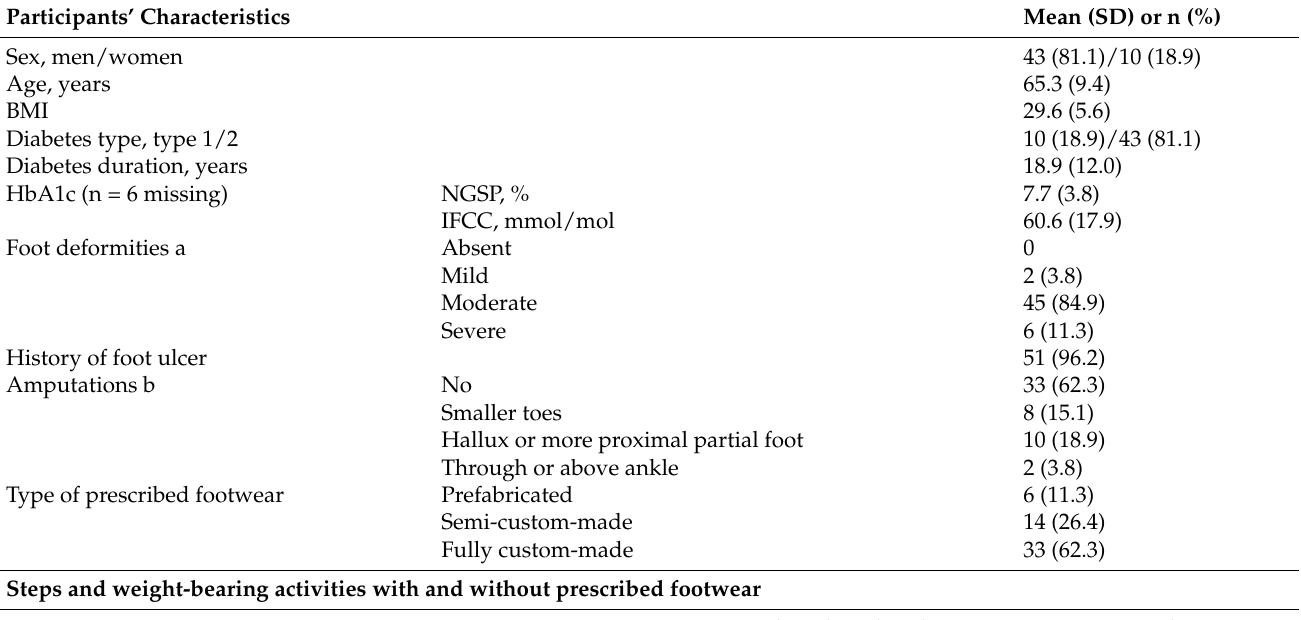
Characteristics of study participants and daily activities with and without pre- scribed